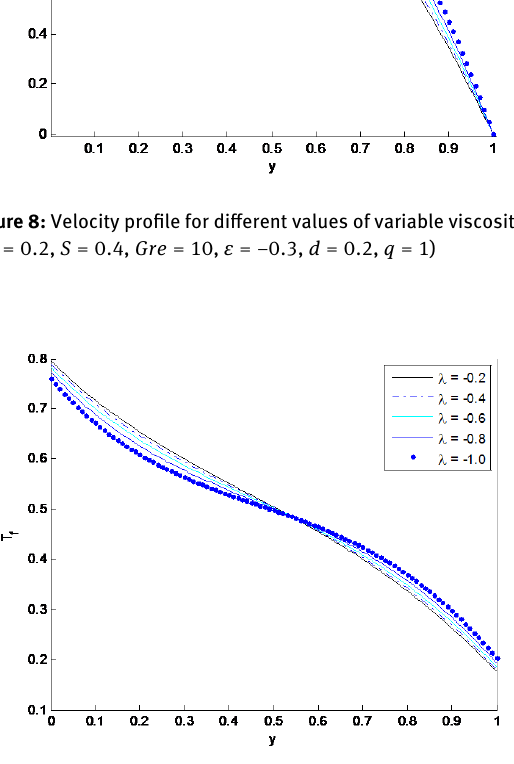
Figure 9: Temperature profile for different values of variable viscos- ity λ ( Br = 0.2 , S = 0.4 , Gre = 10 , ε = −0.3 , d = 0.2 , q = 1